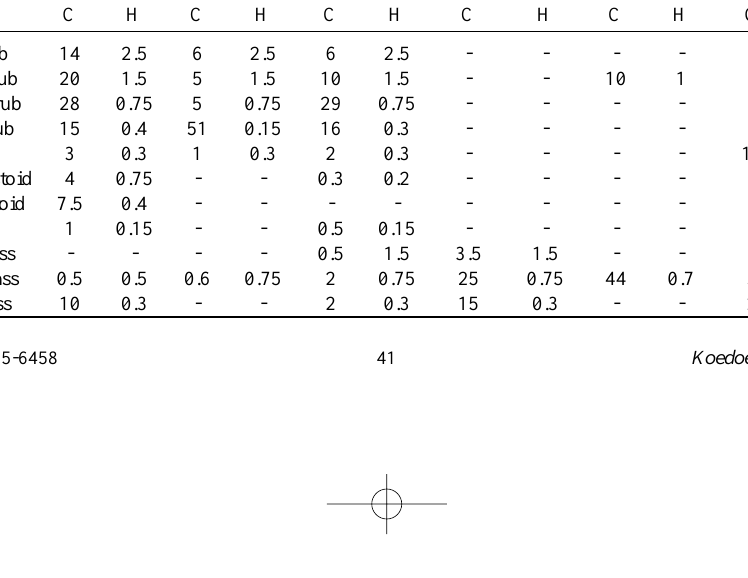
Percentage Cover (C ) (%) and Height (H)(m) of the strata of the main plant communities